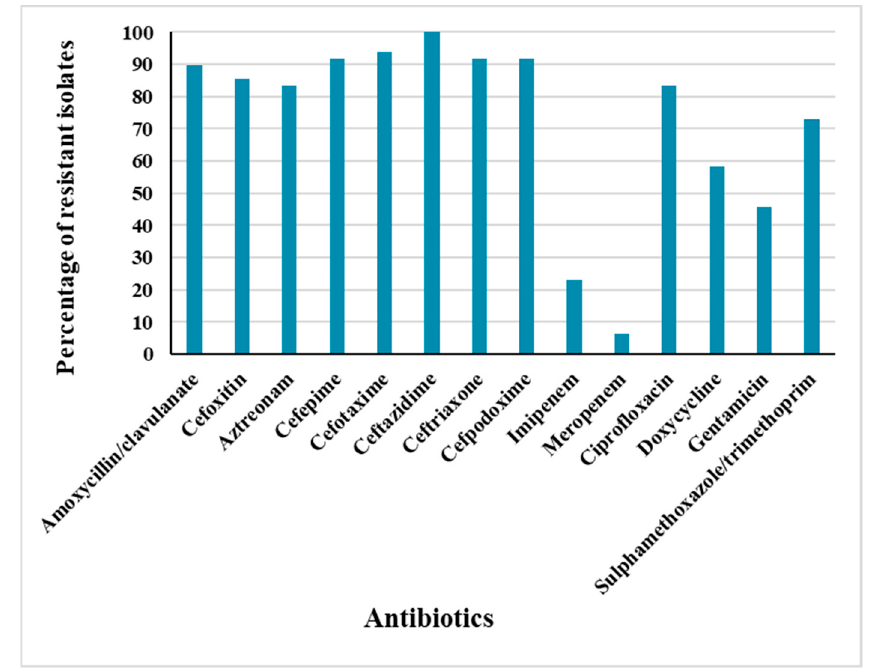
Figure 1. Antibiotic resistance rates among 48 tested E. coli